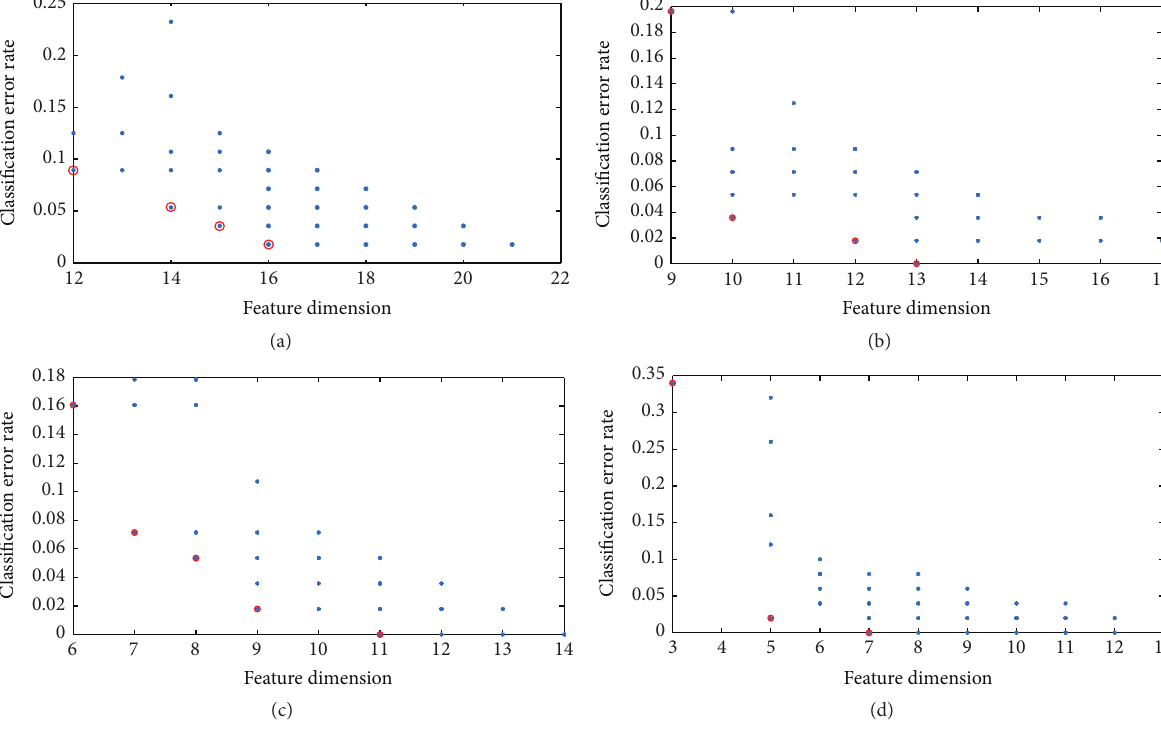
Figure 12: Distributions of the solutions at different generations over the objective plane utilizing the NSGA-II based on the candidate feature : (a) 10 generations; (b) 20 generations; (c) 40 generations; (d) 60 subset 𝐹 mRMR